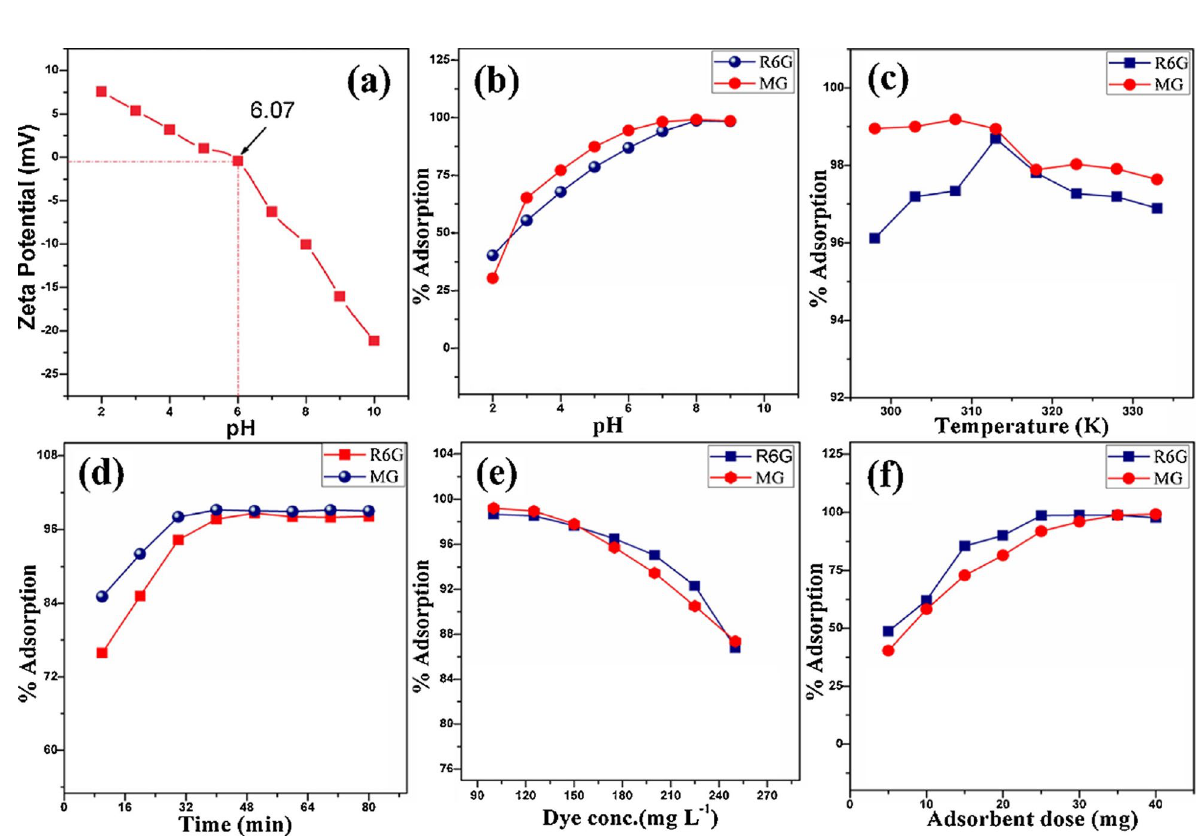
Fig. 11 Different parameters for removal of dyes. a Zeta potential variation with pH, b – f Dye conc-100 ppm; Ads dose-30 mg(R6G) and 40 mg(MG), Temp-313 K (R6G) 308 K (MG); Eq.timwe- 50 min